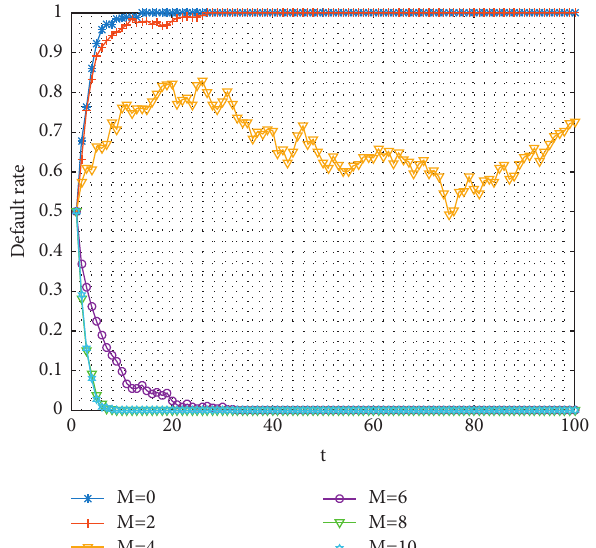
Figure 5: The effect of the punishment mechanism on the spread of default behavior in a small-world network.